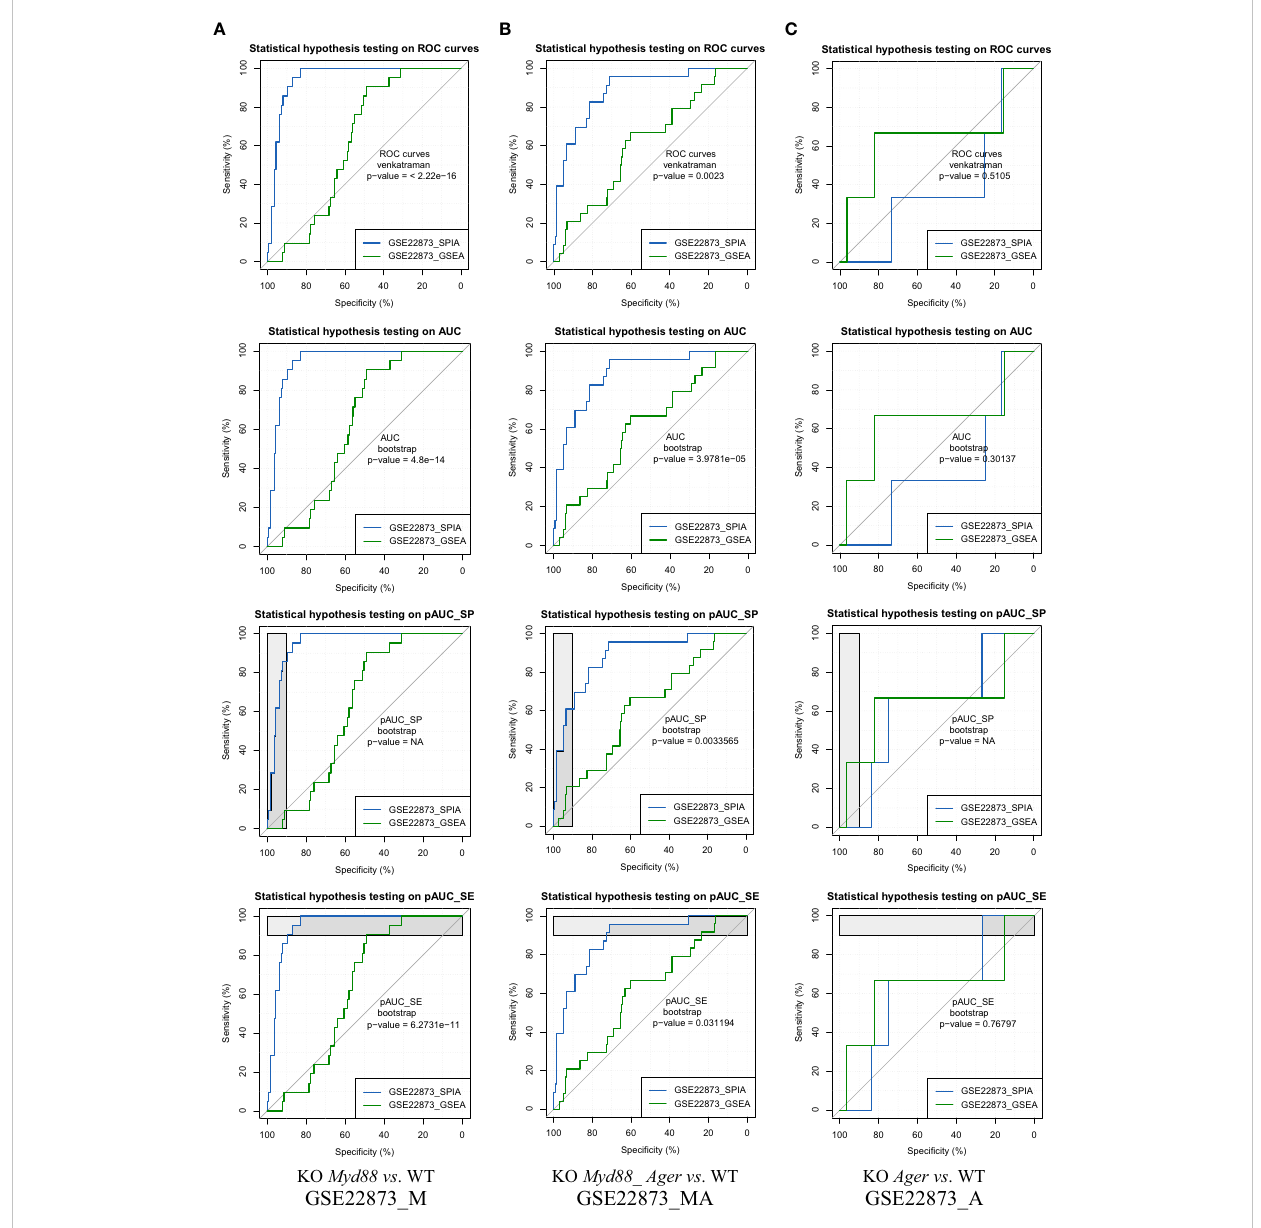
FIGURE 7 ROC curves-based statistical hypothesis testing of key metrics. The top-panel is testing the two ROC curves themselves ( via the venkatraman method). The remaining panels are testing the AUC, pAUC_SP and pAUC_SE values ( via the bootstrap method). (A) GSE22873_M; (B) GSE22873_MA; (C)